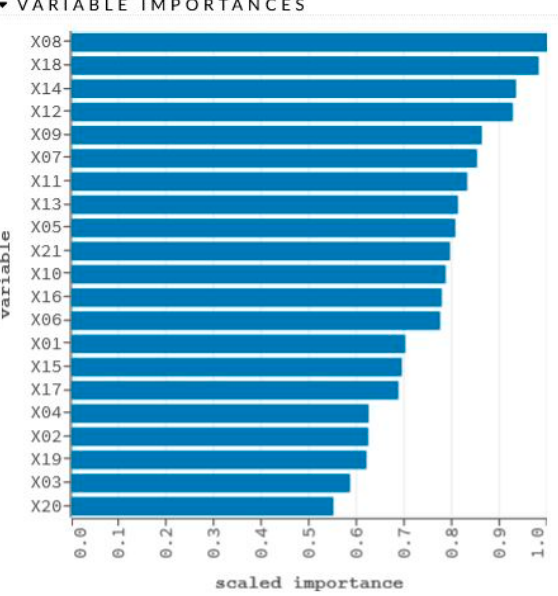
Figure 7. Graphical representation of sensitivity analysis of variables.